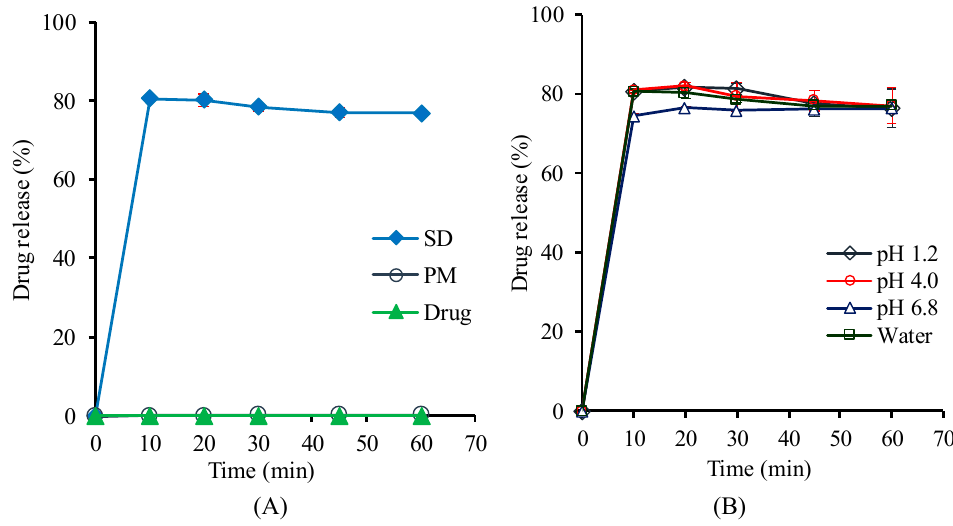
Figure 6. Drug release profiles of the optimal SD formulation (F8-SD) in water. Data are expressed as the mean ± standard deviation (n = 3). ( A ) Comparison of SD, PM, and pure drug; ( B ) drug release profiles of F8-SD at different pHs.